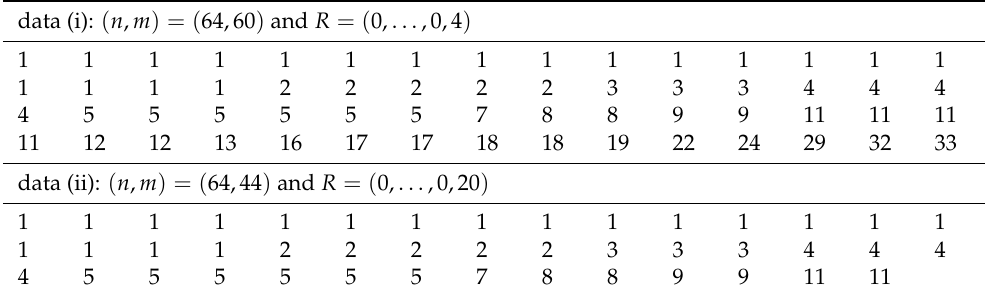
Table 6. Progressively Type-II censored samples from agricultural machine motor data.